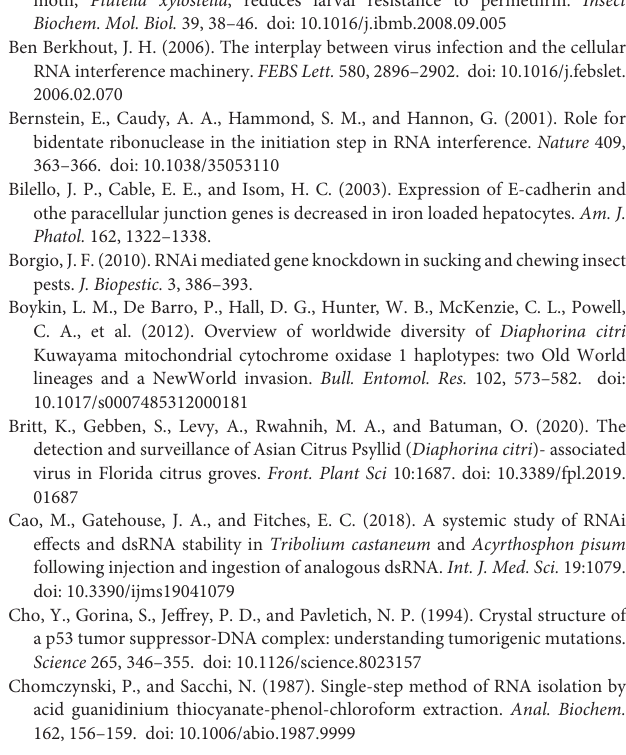
Supplementary Figure 1 | Fluorescence image (4X microscopic magnification) of leaf sample inoculated with CTV- gfp . Supplementary Figure 2 | Right side , Scatter plot of contigs matching mRNA sequenced from psyllid guts post paratransgenic CTV- RIE and CTV- gfp (control) oral uptake. Yellow contigs are equally expressed in guts from psyllid CTV-RIE or CTV-gfp paratransgenic leaves, red contigs overexpressed in CTV-RIE ACP, blue contigs overexpressed in CTV-gfp fed ACP (or under expressed in CTV-RIE fed adult Asian psyllids). The most significant (99% of contigs expression > 8-fold) of under and over expression is represented by white contigs (on axes). Left side , 25 of 149 of these contigs have been annotated and quantified by relative RNA abundancies as read per million (RPM) showing underexpressed and overexpressed contigs (negative and positive fold changes, respectively) in CTV-RIE paratransgenic citrus fed